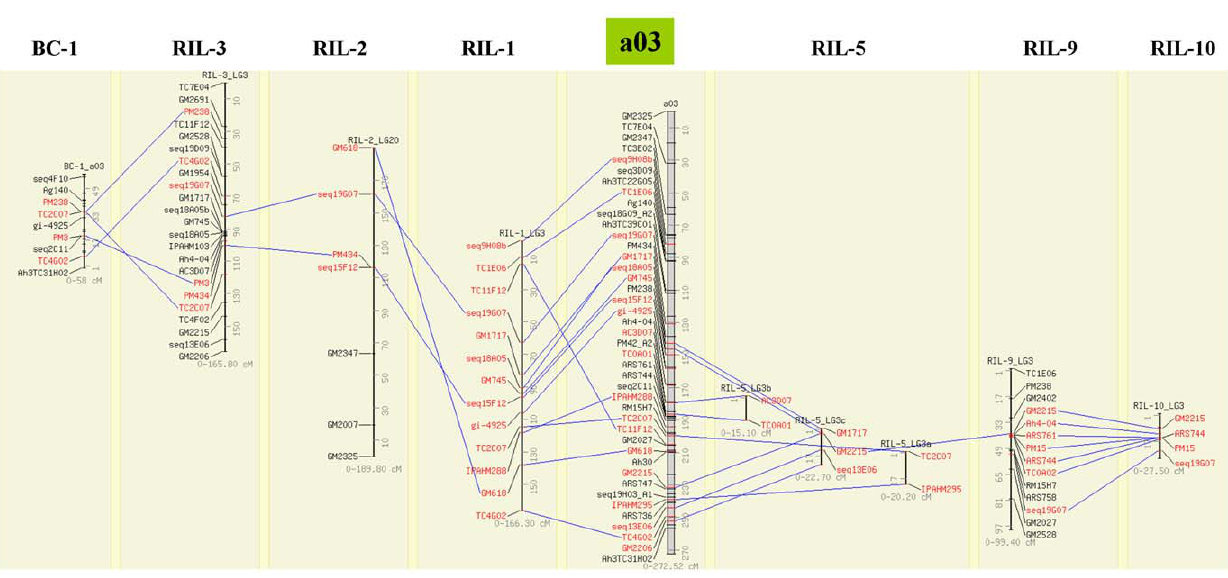
Figure 2. A marker based correspondence for a03 among reference consensus and individual genetic maps. Only common markers i.e. landmarks are included to visually asses the co-linearity of marker orders and marker positions. LGs are aligned together using comparative mapping program CMap version 1.01. Figure can also be accessed from http://cmap.icrisat.ac.in/cmap/sm/gn/gautami/.